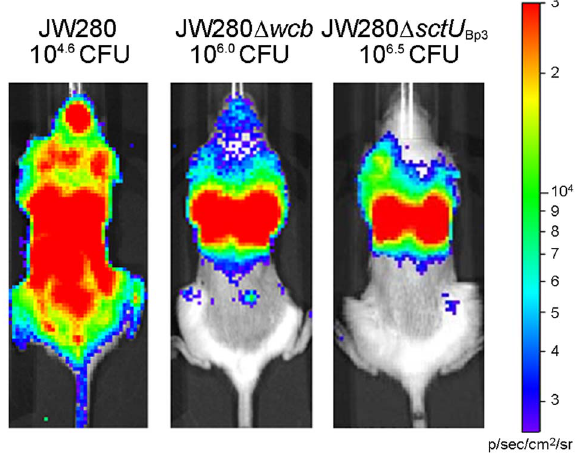
Fig. 6. Detection of dissemination of B.pseudomallei mutants by optical imaging. Groups of 5 female albino C57BL/6J mice were challenged by the IMIT route of infection with either wild type luminescent B. pseudomallei strain JW280, the D wcb capsule mutant, or the D sctU Bp3 T3SS3 mutant. Representative images of disease endpoints are presented, with uniform image settings adjusted to a range of 2.5 6 10 3 to 3 6 10 4 p/s/cm2/sr on a logarithmic scale.